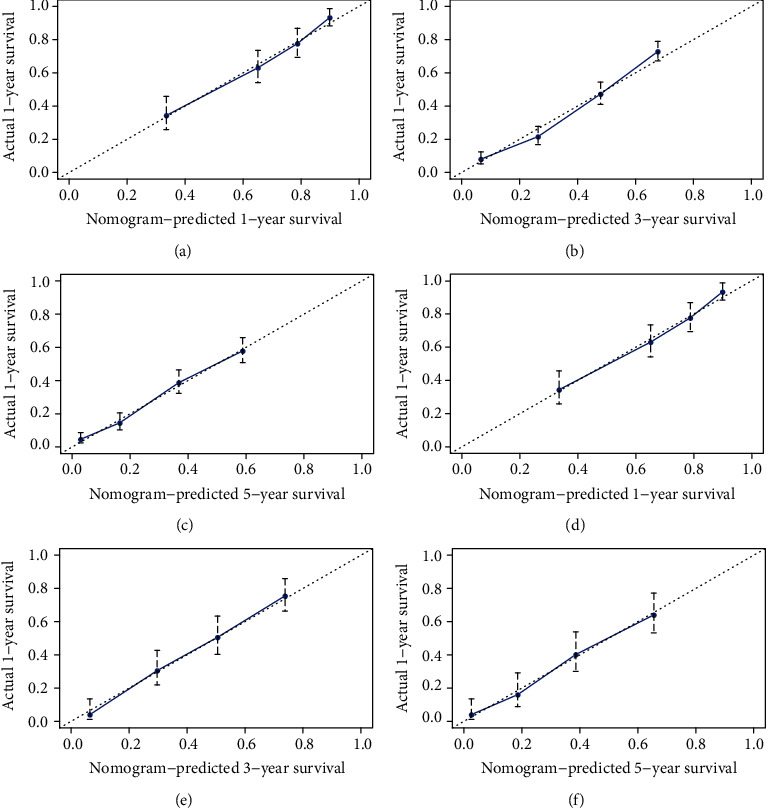
1-, 3-, and 5-year OS forecasted nomogram calibration graphs for the training cohort (a-c) and internal validation cohort (d–f). The x-axis represents the OS probability predicted by the nomogram; the y-axis represents the actual survival rate. Diagonal lines represent ideal reference column diagrams. Striped dots represent the probability of the nomogram prediction and the 95% confidence interval.